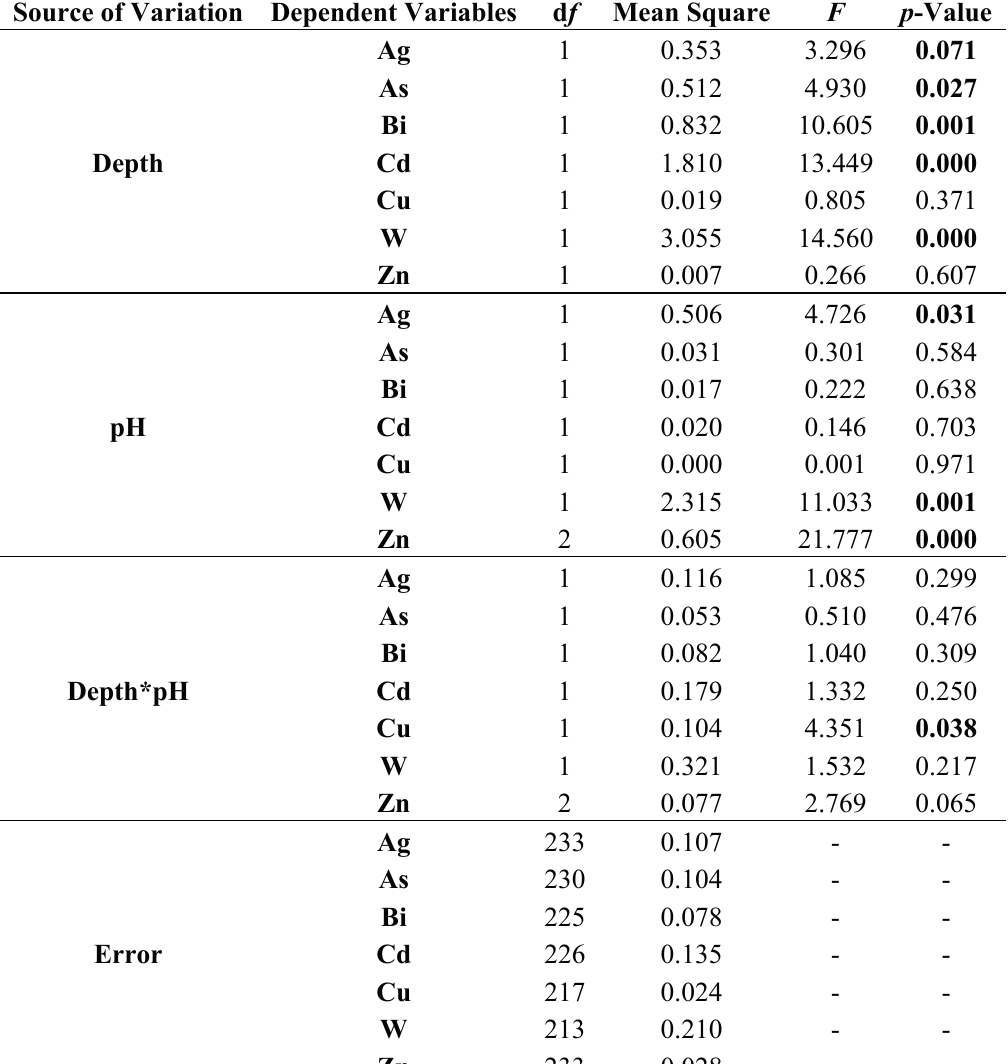
Table 7. Two-way ANOVA results between the dependent (PTEs) and independent (depth, pH) variables. PTEs were subjected to log-normal transformation (As, Bi, Cd, Cu, W, Zn with α = 0.050; Ag with α = 0.075).